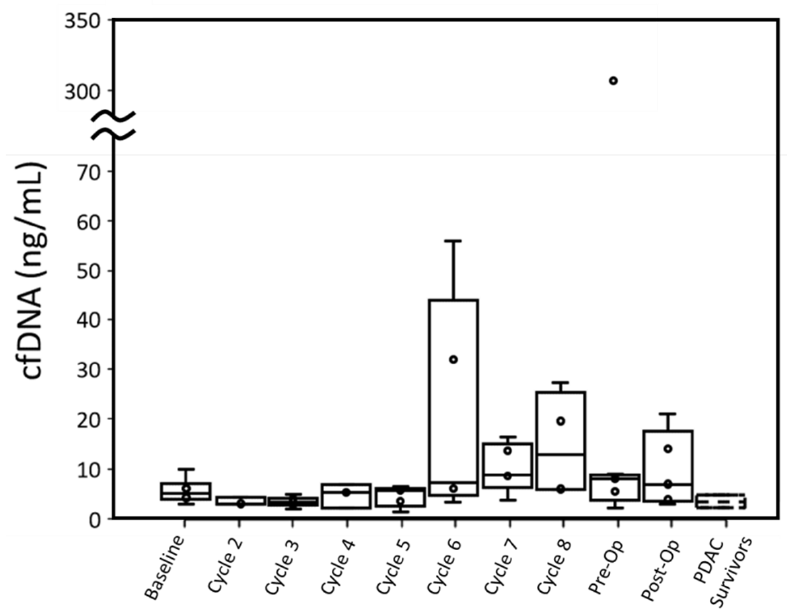
Figure 3. Trend of cfDNA concentration of all patients measured by ddPCR over the treatment cycle, pre-operation (pre-OP) and post-operation (post-OP). PDAC survivor samples are included for comparison. The whiskers represent the minimum and maximum; the box bottom, the bar inside the box, and the box top represent lower quartile, median, and upper quartile; the cross represents the average; and each circle represents one data point.